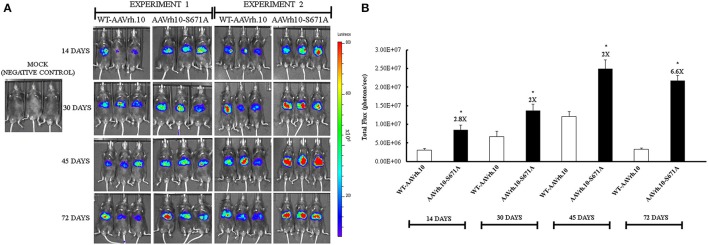
Transduction characteristics of AAVrh.10-S671A mutant vectors in vivo. (A) Luciferase activity was detected at different time points after gene transfer with 5 × 1010 vgs/animal of WT-AAVrh.10 or AAVrh.10-S671A vectors. Two independent sets of packaged vectors were used for the in vivo experiments 1 and 2. (B) Quantification of data from panel a. *p < 0.05, when compared to the WT- administered mice. Representative images are shown in the figure.